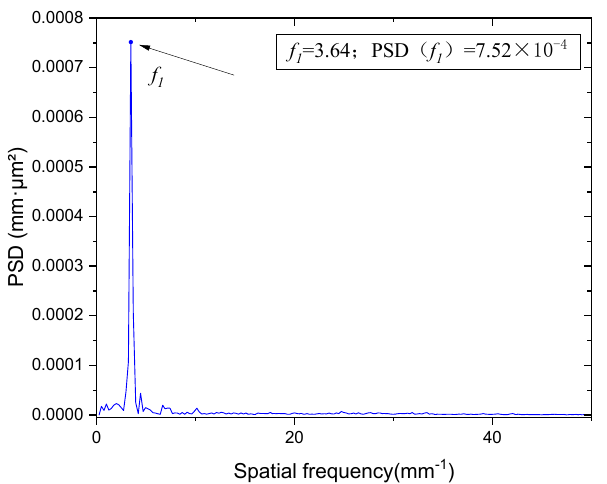
Figure 7. One-dimensional power spectral density curve in the feed direction.